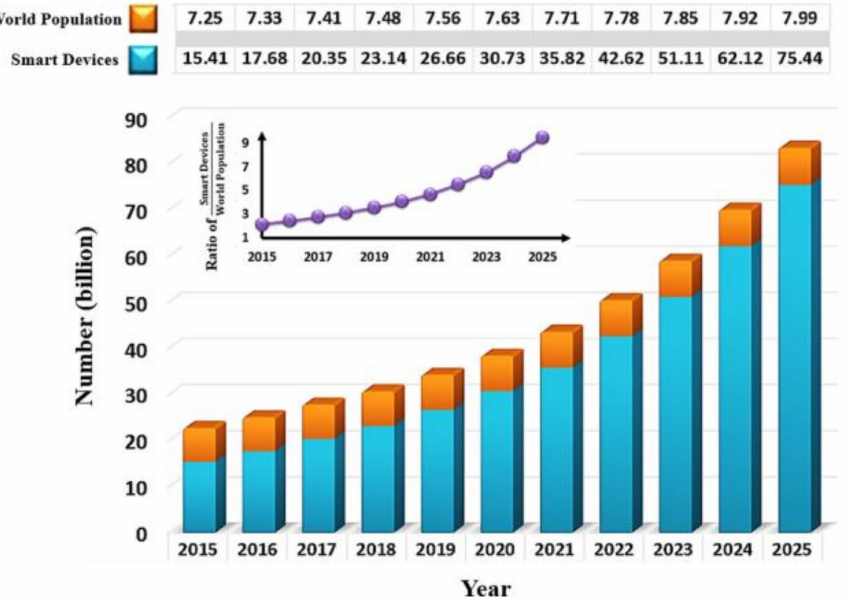
Figure 2. Quantity of projected smart devices connected to the Internet with the estimated world population